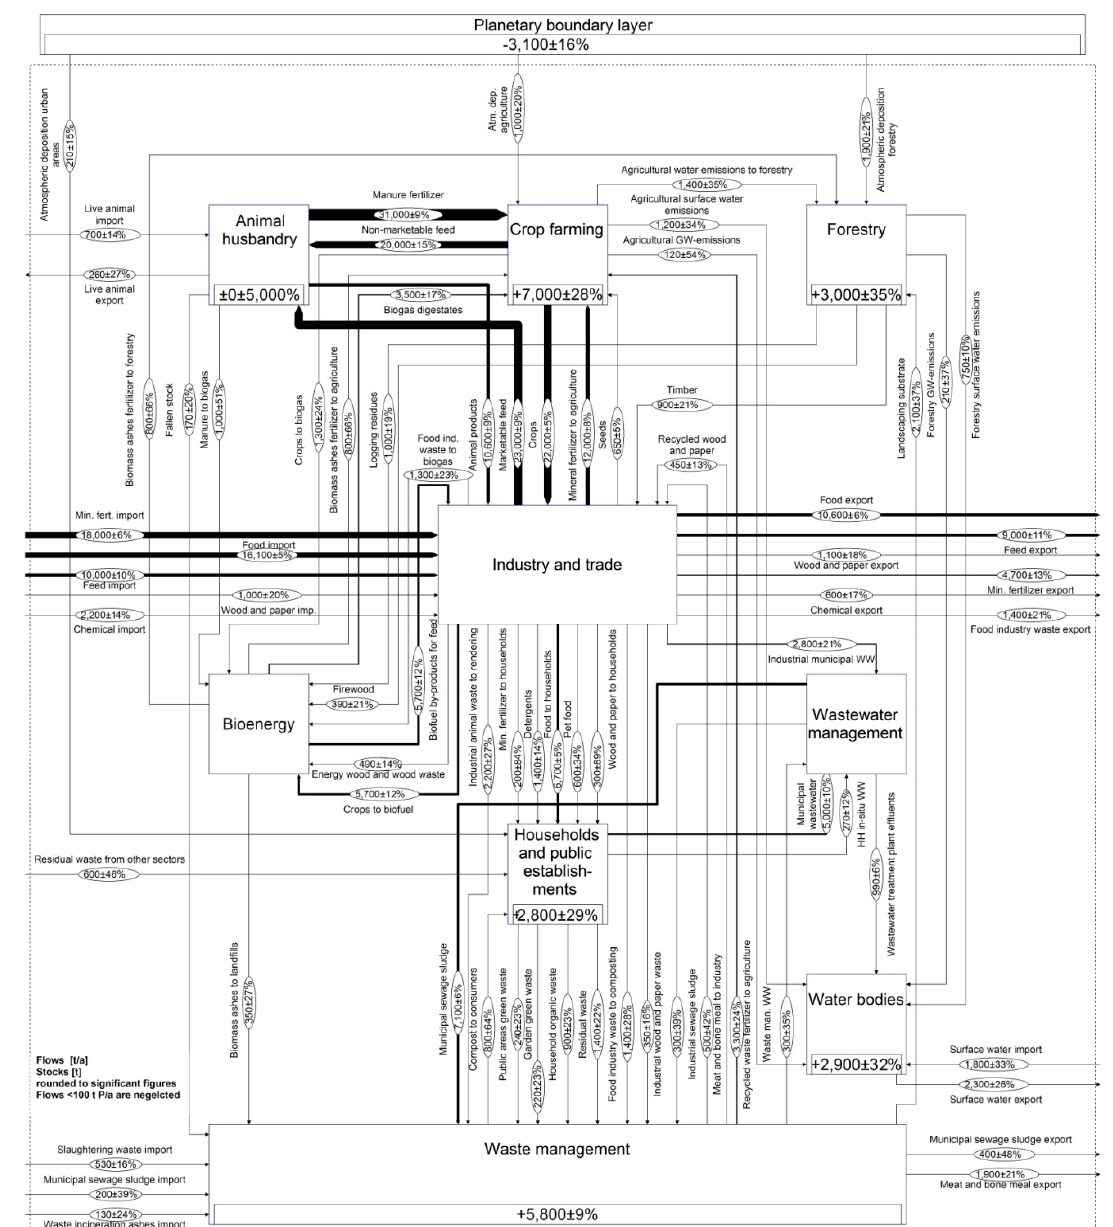
Figure 1. The Austrian P system 2015.